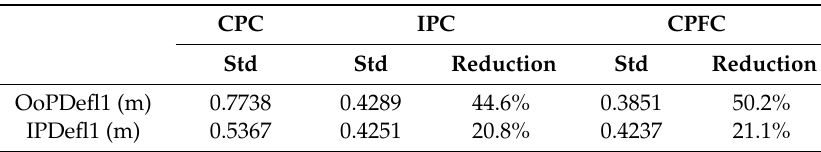
Figure 9. The PSD analysis of blade root out-of-plane bending moments.